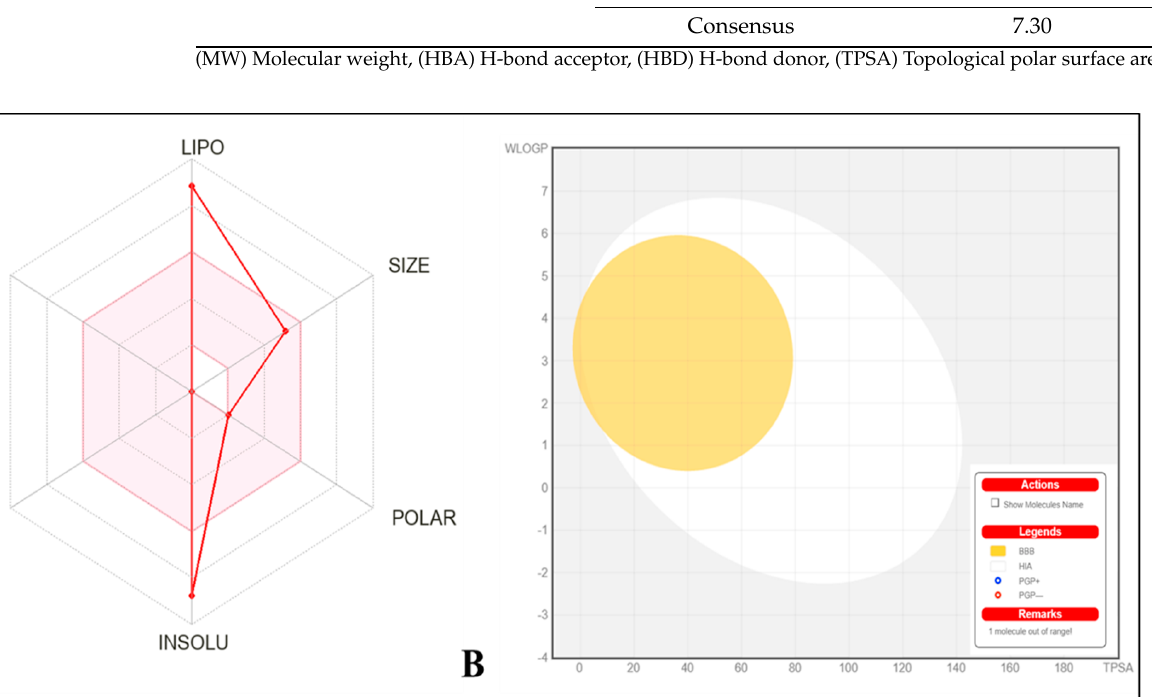
Table 6. EFD’s predicted physicochemical and lipophilic profile.